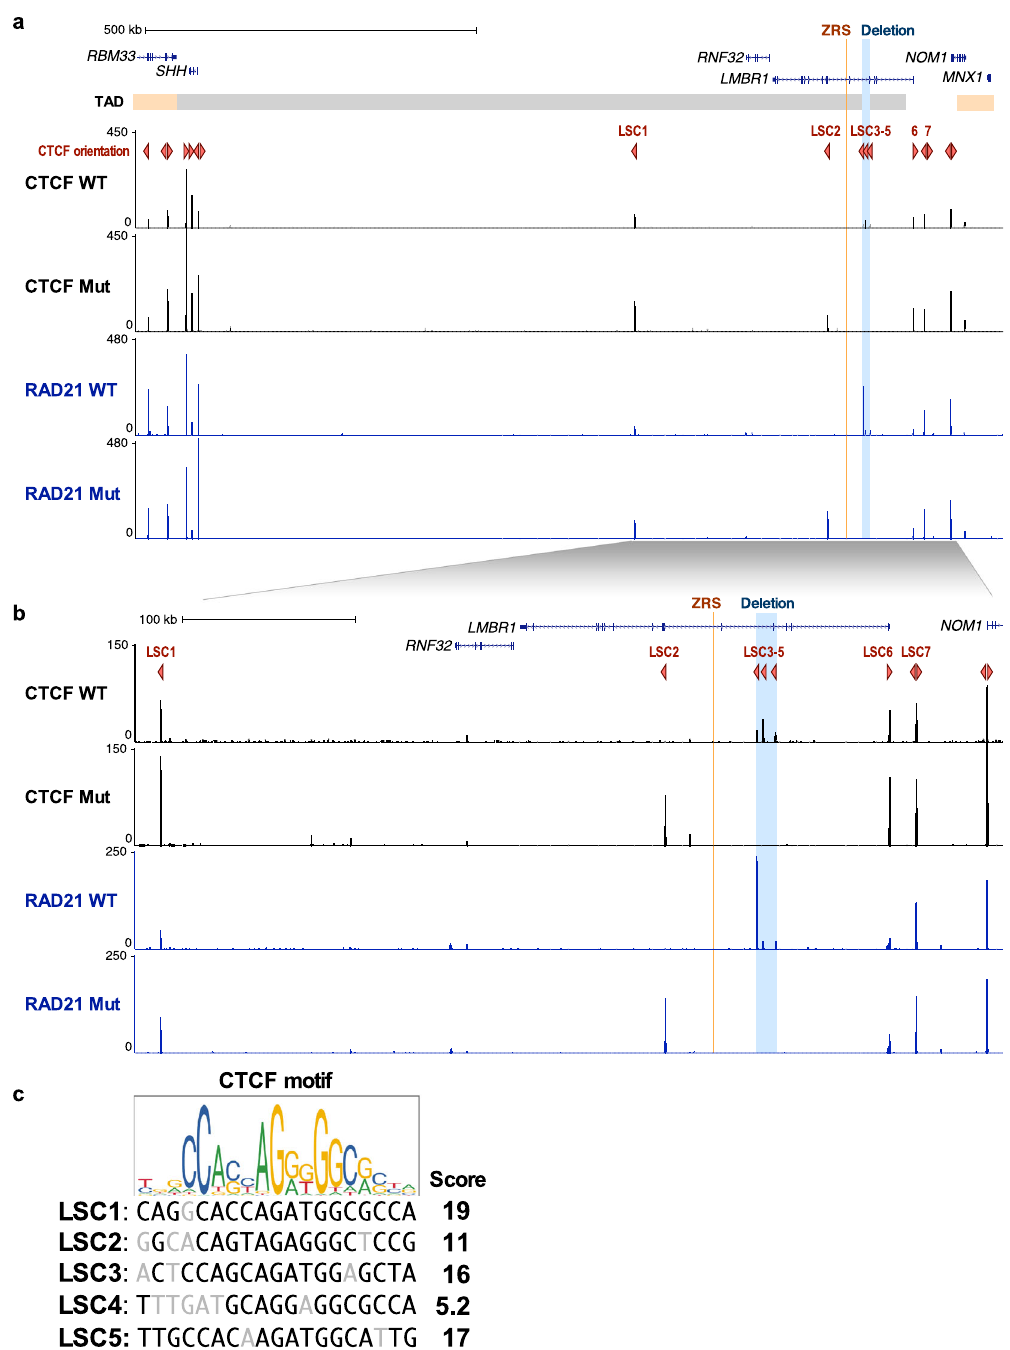
Fig. 3 CTCF and RAD21 distribution in the LMBR1-SHH locus. a CTCF and RAD21 ChIP-seq enrichment in lymphoblastoid cells from wildtype (WT) and proband (Mut) at the LMBR1-SHH locus. GM12878 (lymphoblastoid cell line) TAD boundaries are shown in orange and gray horizontal bar. ZRS and the acheiropodia-associated deleted region are shown in orange and blue vertical lines respectively. CTCF orientations are shown as red triangles. The Y -axis is the signal P -value to reject the null hypothesis that the signal at that location is present in the control. b Zoom in of the region around the LMBR1 gene.